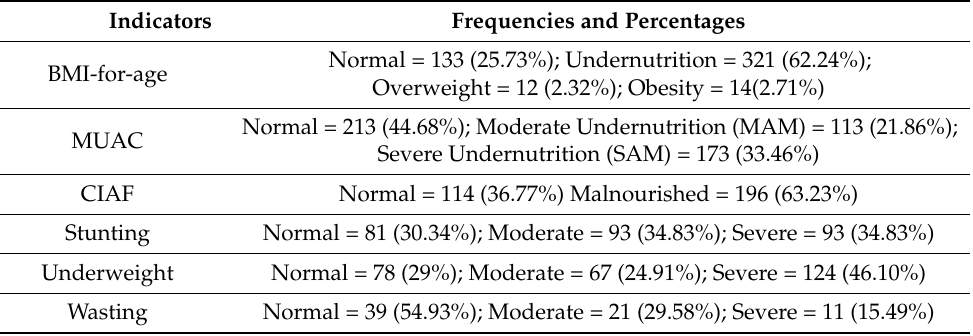
Table 3. Overall Malnutrition Prevalence (Frequencies and percentages) among children through different approaches.